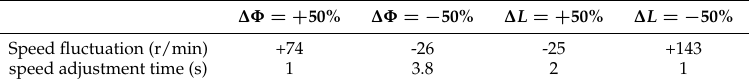
Figure 14. Speed response curves under GPC+ESO method with a sudden change of inductance value. ( a ) ∆ L = + 50%; ( b ) ∆ L = − 50%. Table 3. The internal disturbance rejection